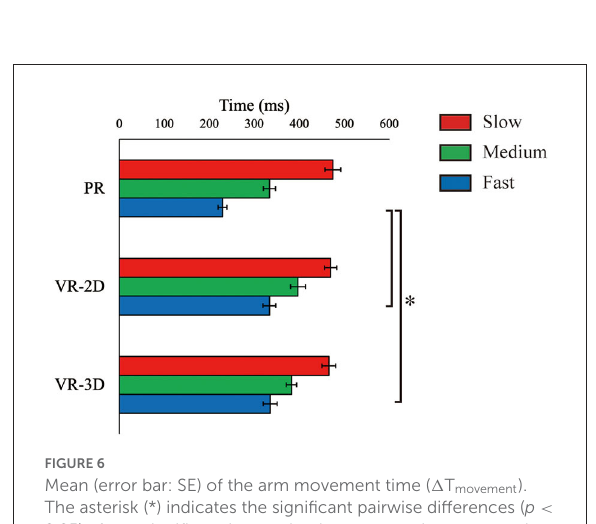
FIGURE6 Mean (error bar: SE) of the arm movement time ( 1 T movement ). The asterisk (*) indicates the significant pairwise differences ( p < 0.05) after a significant interaction between environment and ball speed was